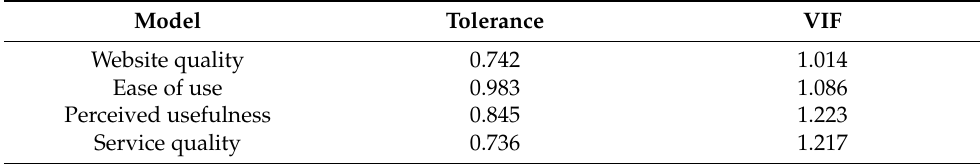
Table 5. Regression model’s tolerance level (N = 142).